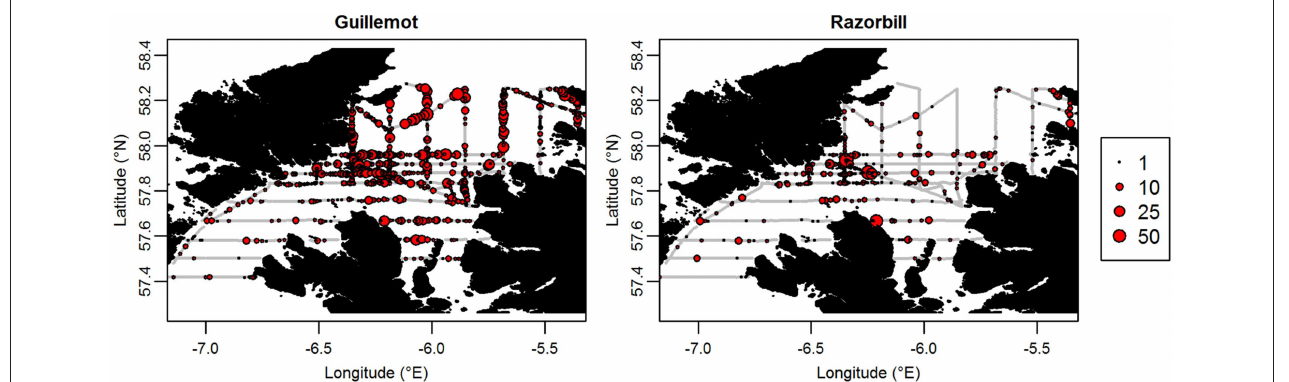
FIGURE 4 | Raw abundances from at-sea surveys, after distance